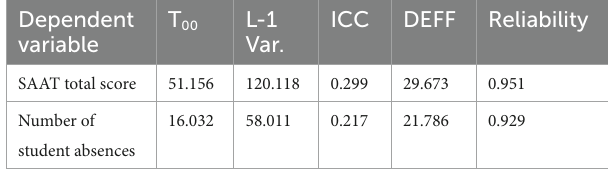
TABLE 1 Descriptive statistics of variables employed in the present study. Variables Mean/